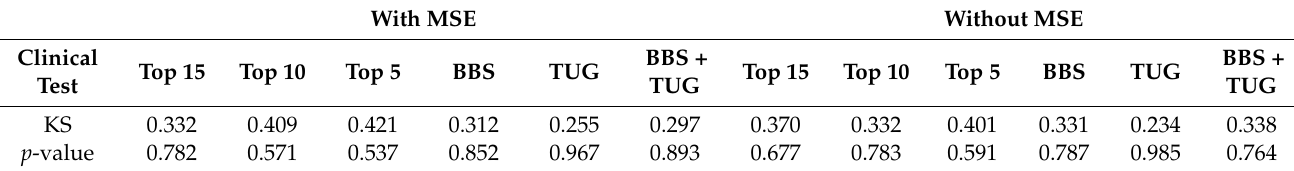
Table 8. Results for the Kolgomorov–Smirnov test for normality. With MSE Without MSE